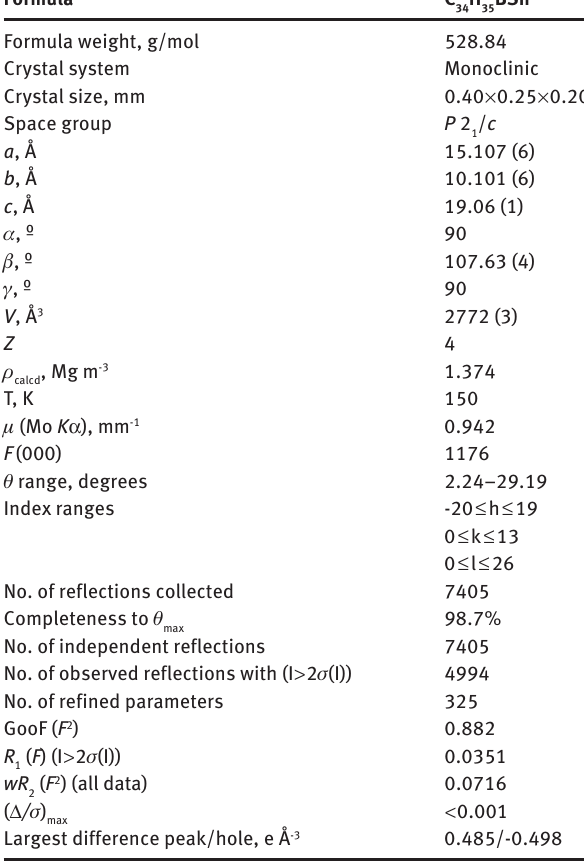
Table 1 Crystal data and structure refinement of (Cp*Sn)BPh